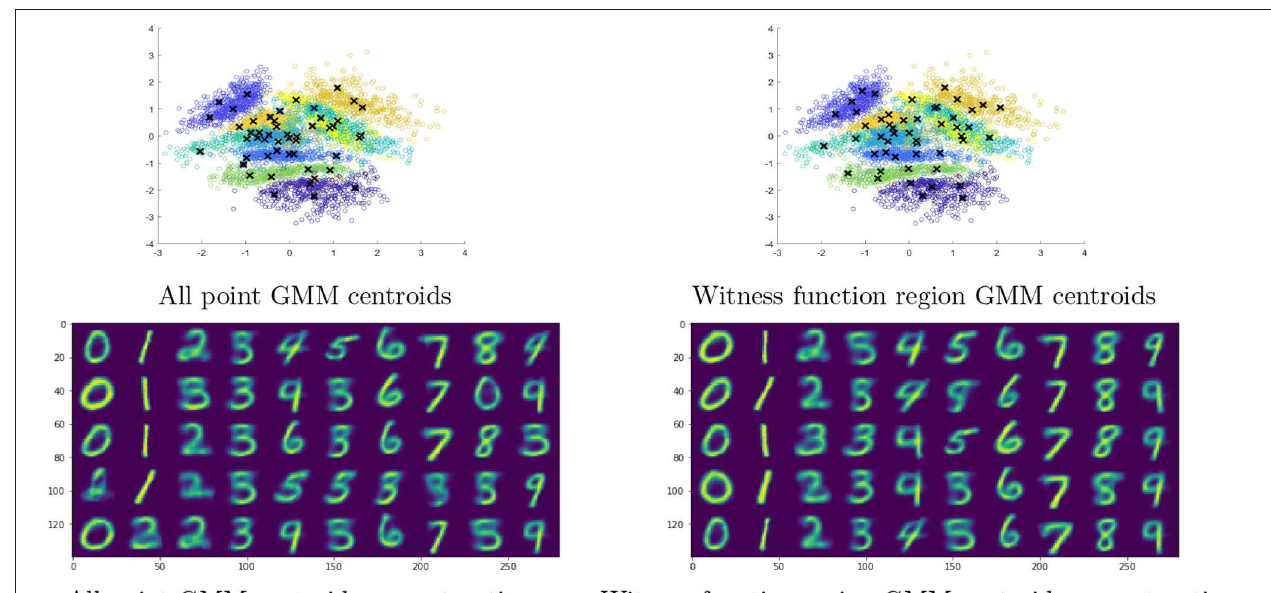
FIGURE 3 | Prototypical points from each class of MNIST digits, computed from 2D VAE